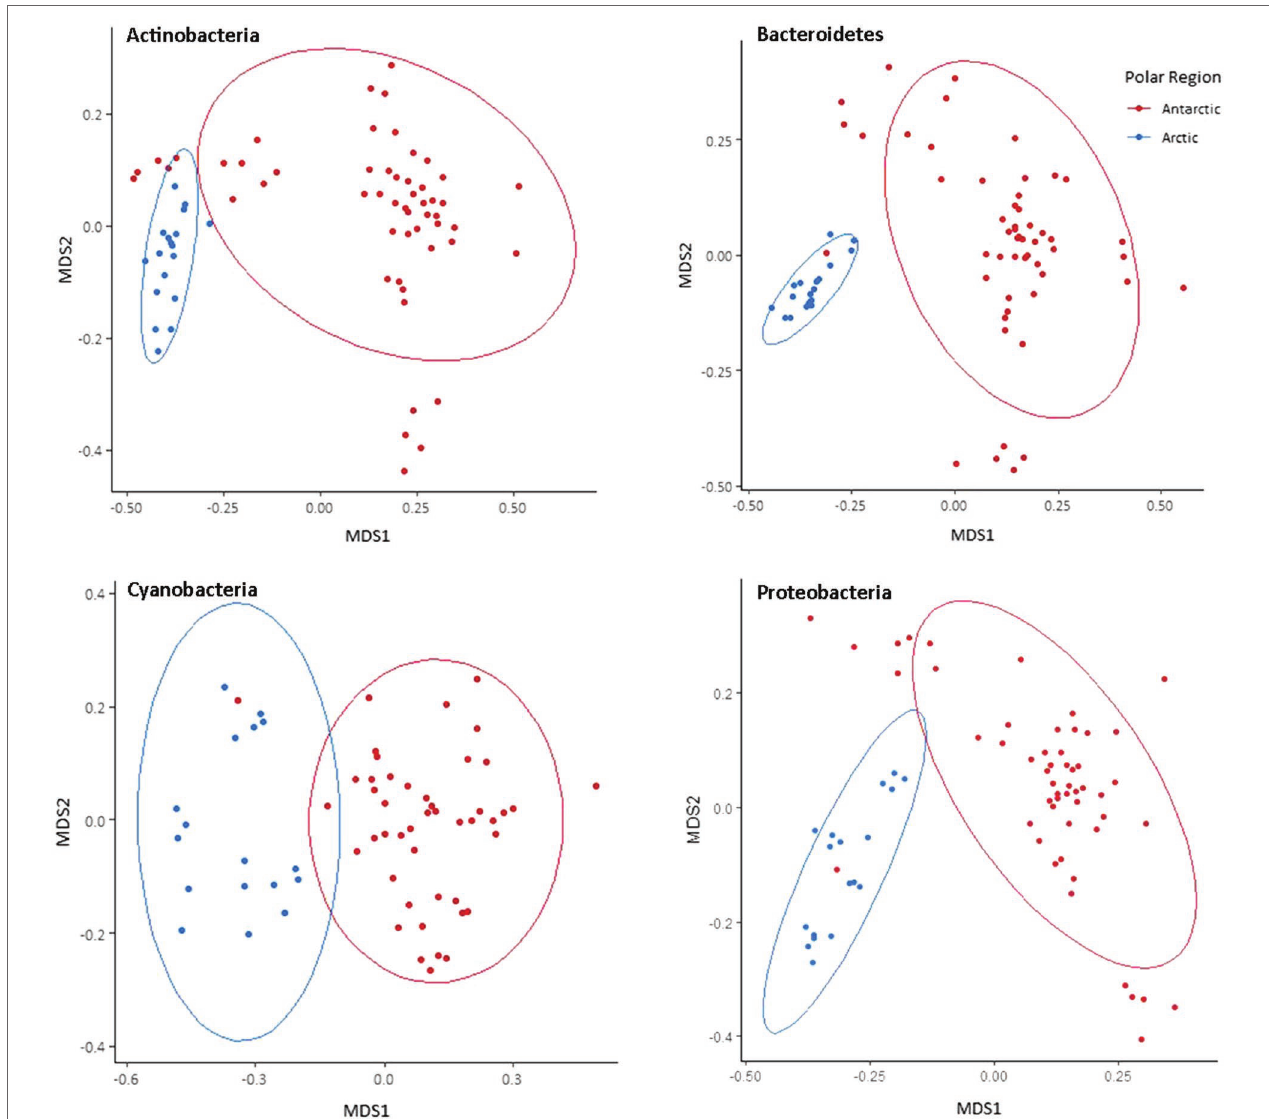
FIGURE 5 | Bray-Curtis dissimilarity of Arctic and Antarctic 16S rRNA gene ASVs in the most abundant four bacterial phyla. Visualised by NMDS ordination. Holes are grouped by polar region. Ellipses represent 95%